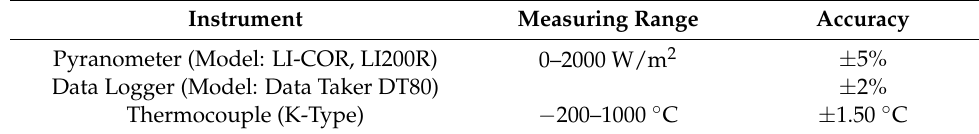
Table 1. Measurement ranges and accuracy of the instruments and sensors.